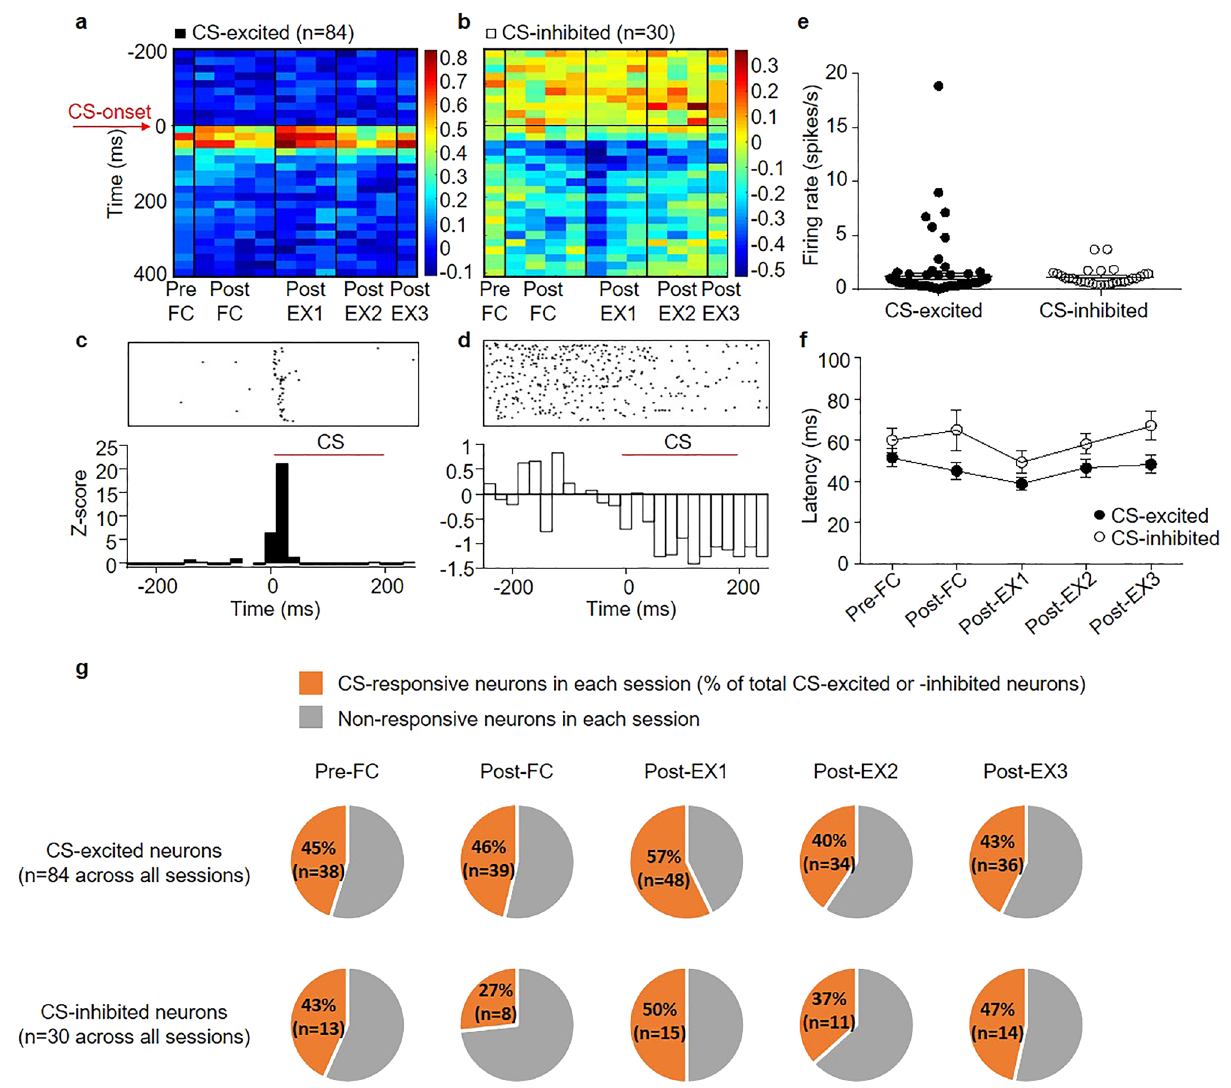
Figure 2. CS-evoked activities of BA L neurons over the entire behavioral training. ( a ) Heatmap showing the averaged z-scores of all the CS-excited neurons (n = 84). ( b ) Heatmap showing the averaged z-scores of all the CS-inhibited neurons (n = 30). Each column in ( a) and ( b) represents the averaged z-scores of five consecutive CS presentations. Each row in ( a) and ( b ) represents 20 ms. The heatmaps were created using MATLAB R2018b (Mathwork, Inc., Natick, MA, USA, www. mathw orks. com). ( c ) Representative raster plot and peri-event time histogram (PETH) of a CS-excited neuron. ( d ) Representative raster plot and PETH of a CS-inhibited neuron. The raster plots were created using NeuroExplorer, Version 4.135 (Nex Technologies, Colorado Springs, CO, USA, www. neuro explo rer. com). ( e ) Spontaneous firing rates of CS-excited and CS-inhibited neurons. ( f ) Latency changes in CS-excited and CS-inhibited neurons over the entire behavioral protocol. ( g ) Pie charts showing the percentage of CS-responsive neurons among CS-excited neurons (top, n = 84 across all sessions) or among CS-inhibited neurons (bottom, n = 30 across all sessions) in a given